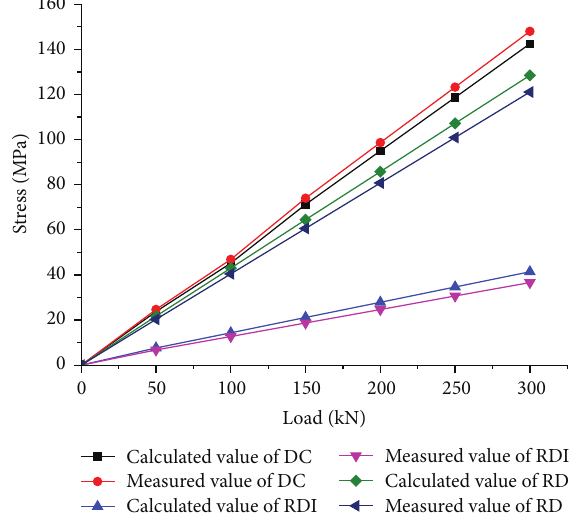
Figure 7: Measured and calculated values of